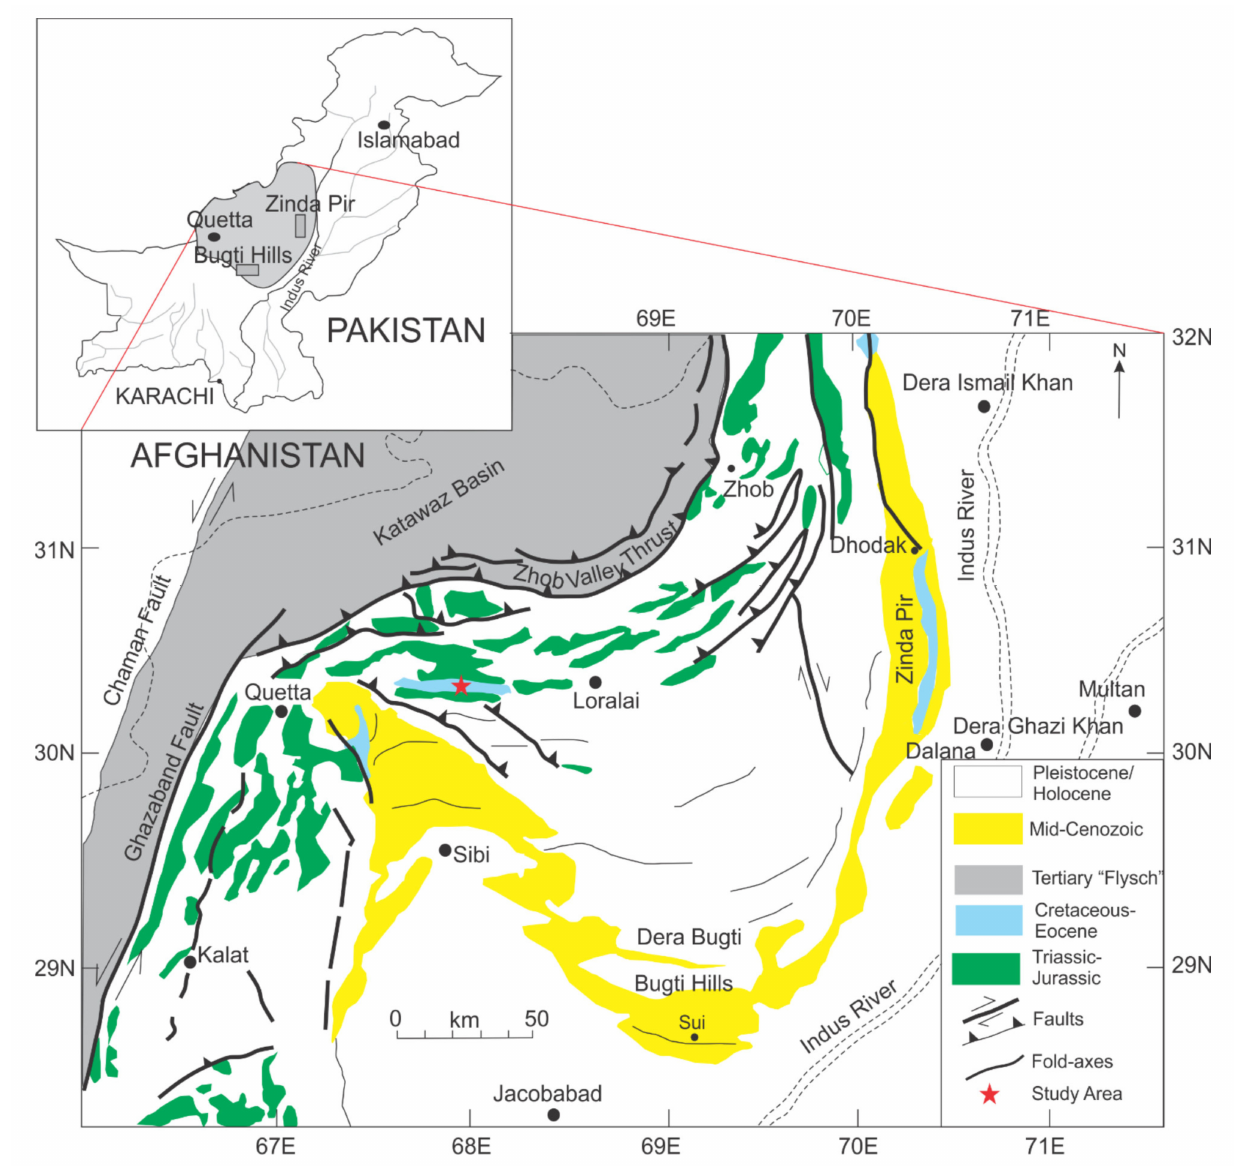
Figure 1. Map showing the study area and distribution of Triassic to Holocene rocks in the Sulaiman Range. (After